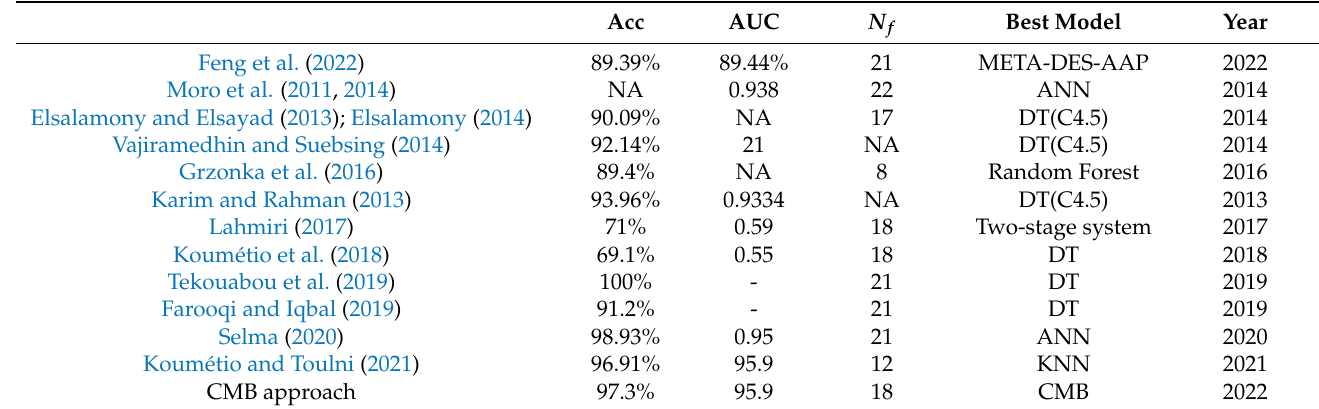
Table 7. Comparison of the best performances of previous work Acc AUC N f Best